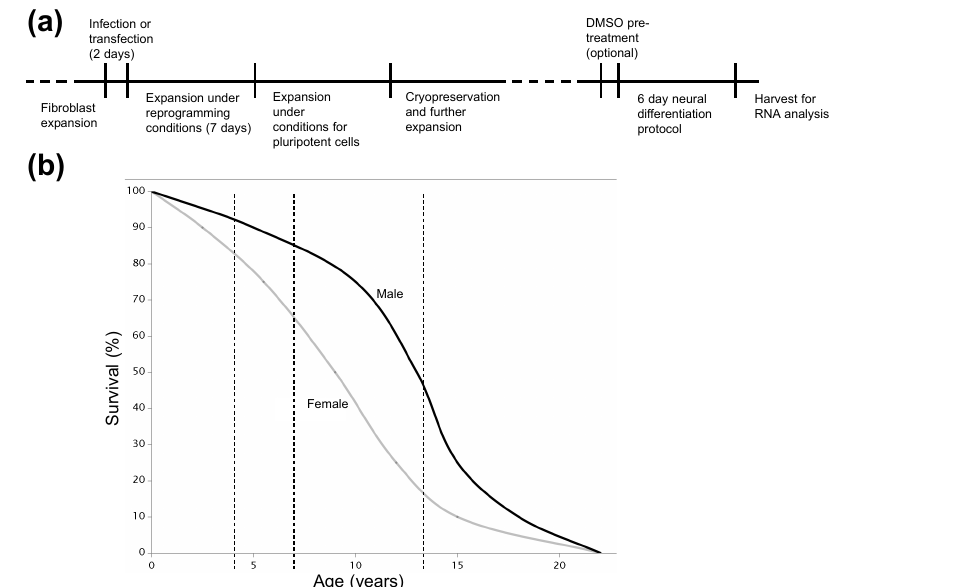
Figure 1. (a) Timeline showing the transition of terminally differentiated cells (fibroblasts) first to iPS cells, through reprogramming, and then to neural type cells using a directed differentiation method. (b) Life span curve of the common marmoset in a closed colony setting. Curve derived by smoothing the graphs reported by Nishijima et al. (2012). Dashed vertical lines indicate the ages of marmoset donors used to generate iPS cells in these studies. The survival pattern in the SNPRC colony from which our samples were derived is very similar to that shown here (Ross et al.,